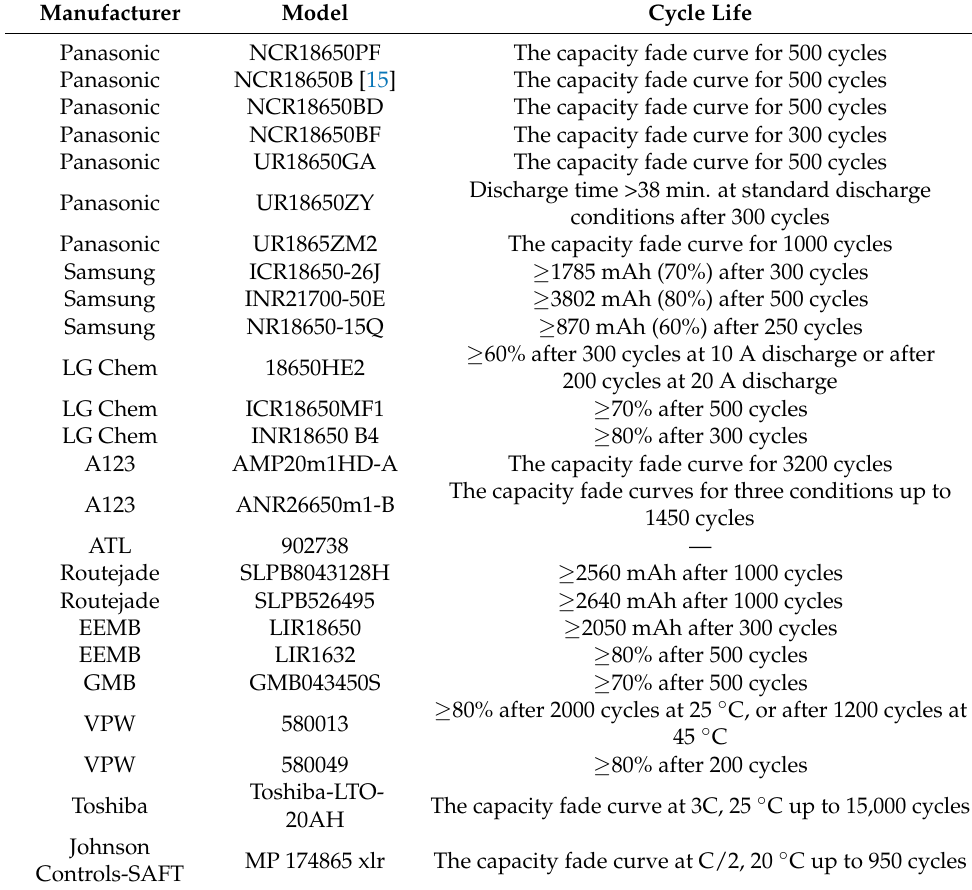
Table 7. Cycle life